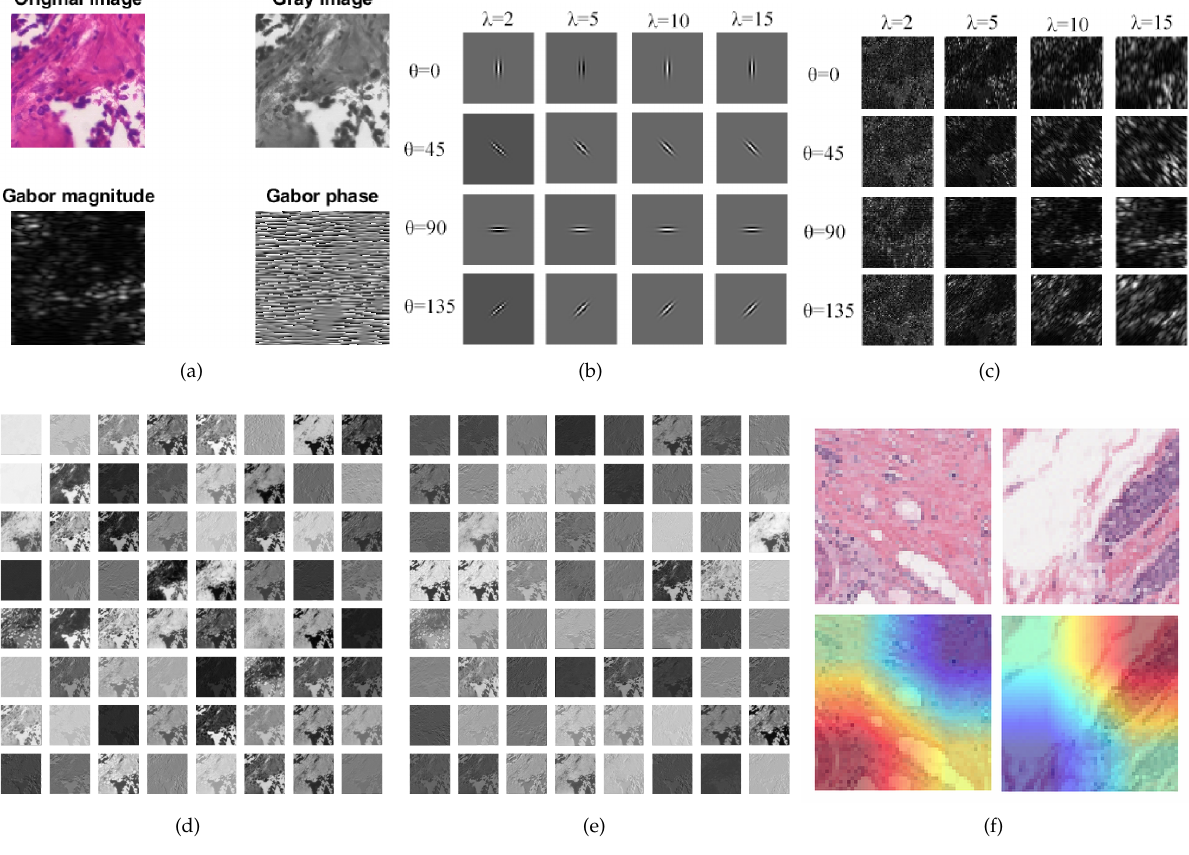
Figure 5. Visualizations: ( a ) Original histopathology image, gray-scale image and the Gabor magni- tude and phase for wavelength λ = 10 and orientation θ = 90. ( b ) Sample Gabor filter bank with different λ and θ values. ( c ) Features extracted with the filter bank. ( d ) Features learned by the first CNN layer of ResNet50. ( e ) Features learned by the second CNN layer of ResNet50. ( f ) Using Grad-CAM to visualize some